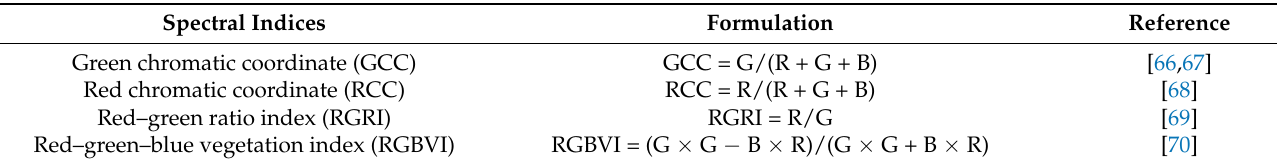
Table 2. Definition of spectral indices used in this study.